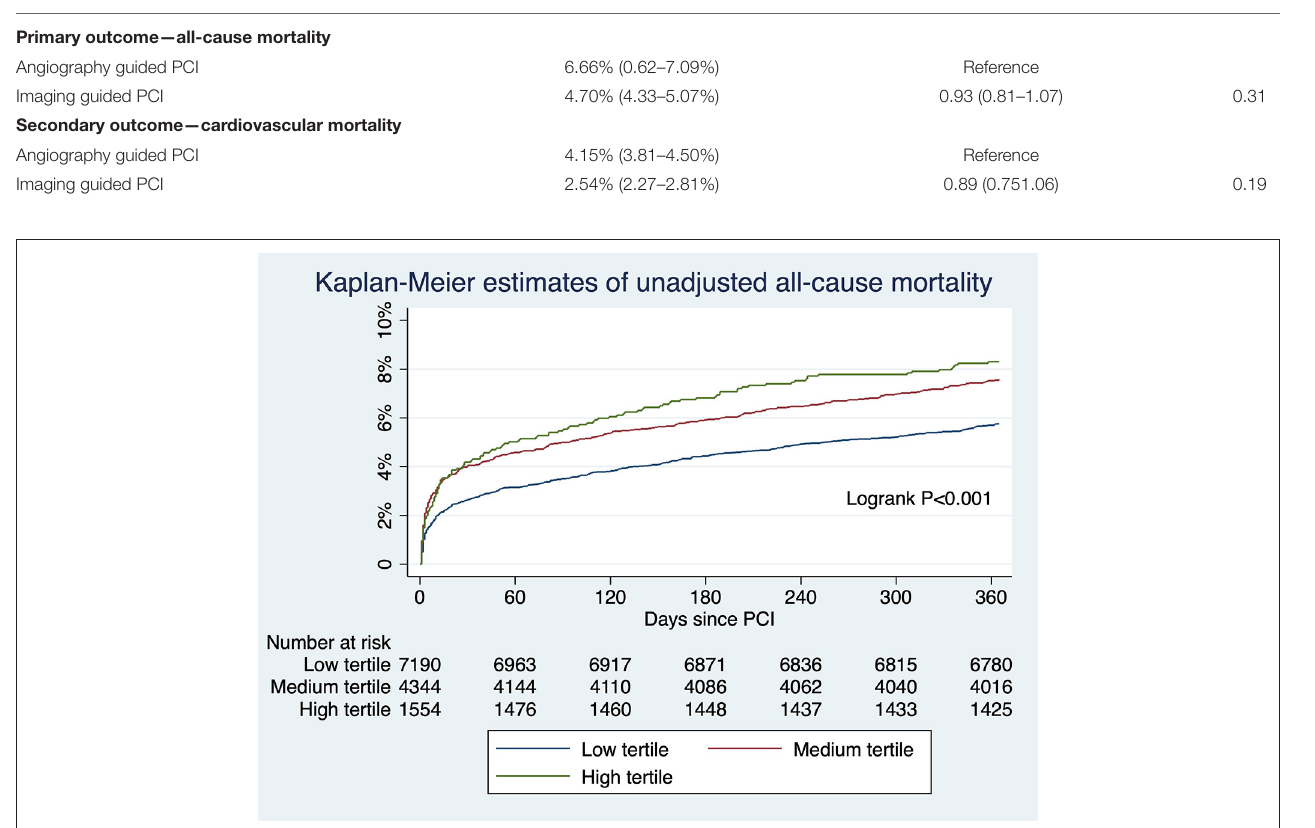
TABLE 4 | Primary and secondary outcomes stratified by imaging guidance. Imaging